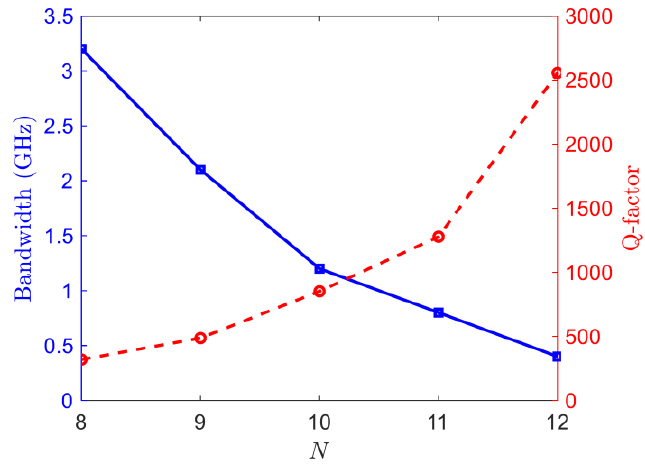
Figure 6. Filter bandwidth (the solid blue line) and the Q-factor (the dotted red line) for the filters with different periods.